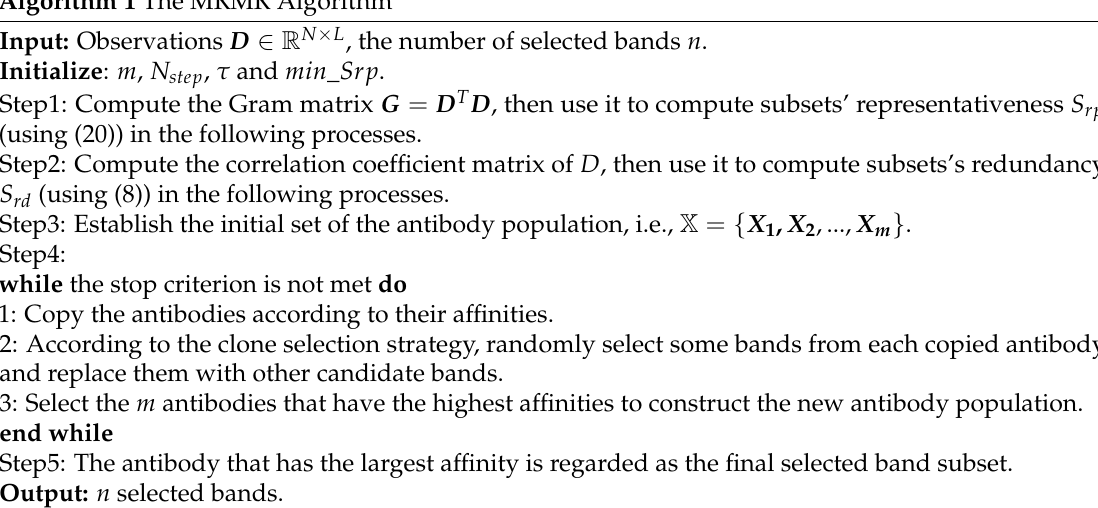
Algorithm 1 The MRMR